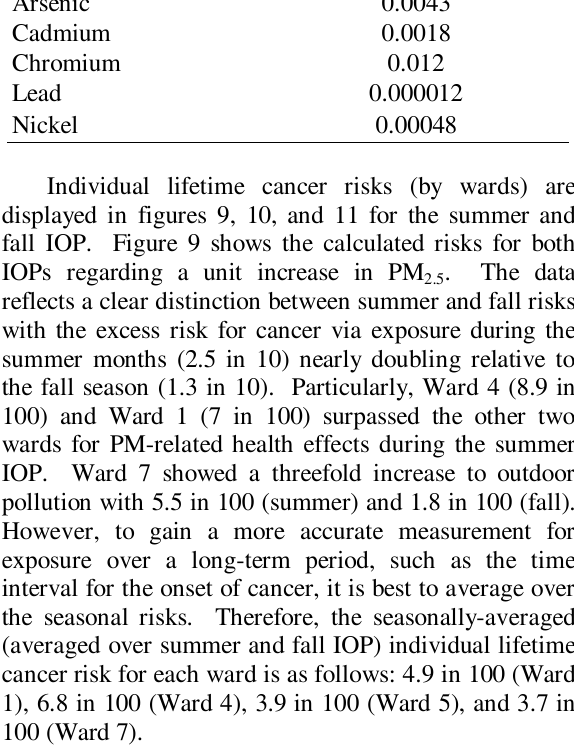
Table 4: Unit Risk Values for PM